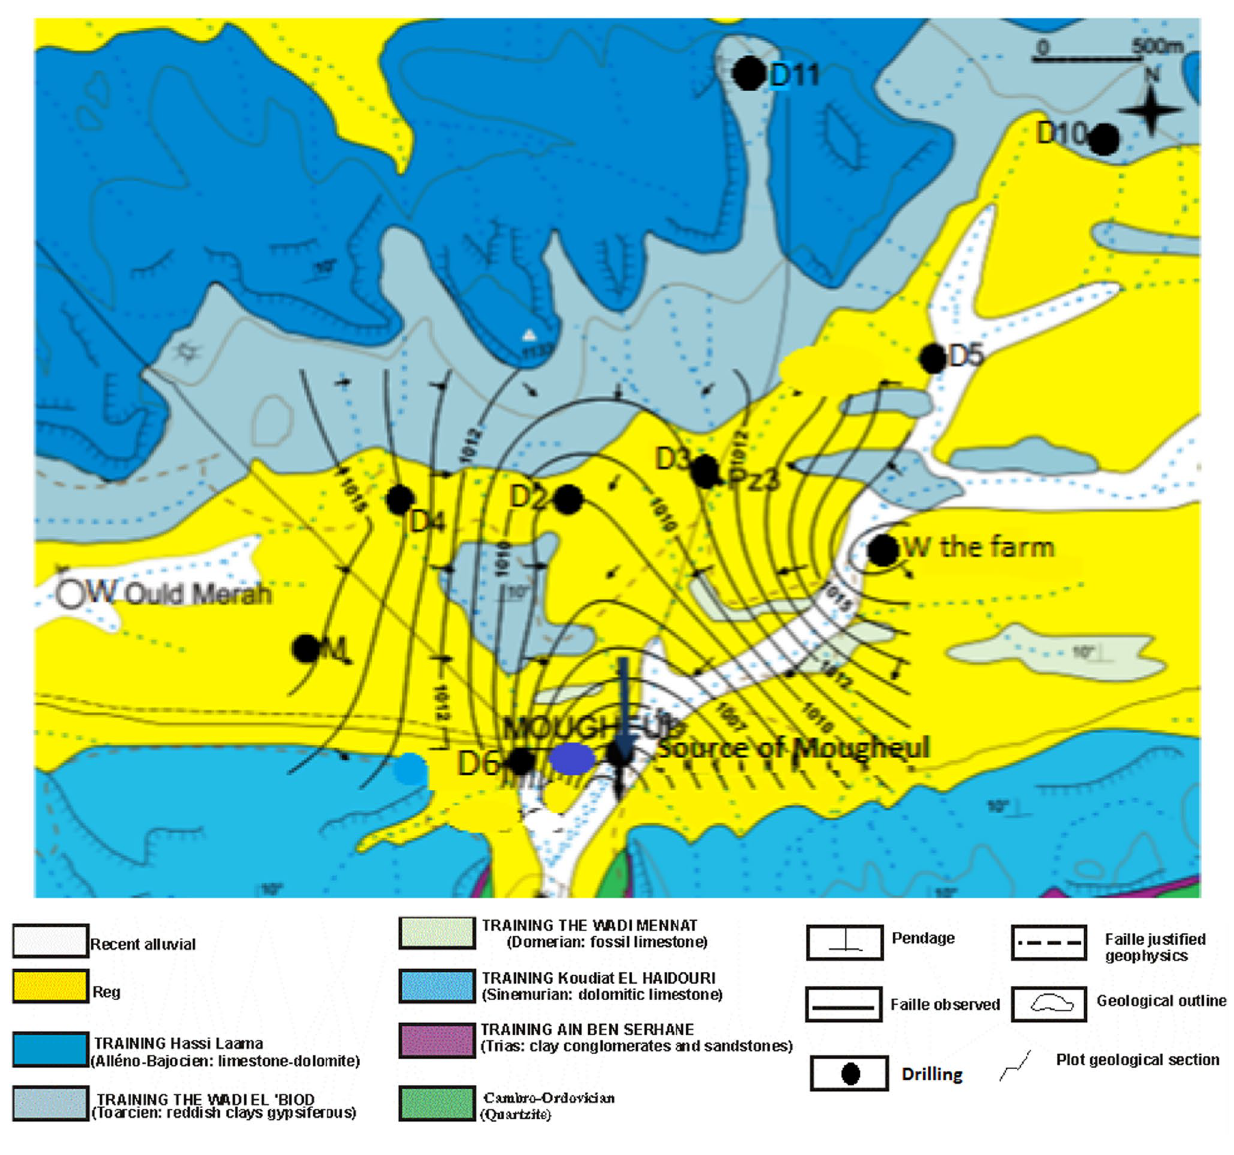
Fig. 4 Piezometric map of the lower Jurassic aquifer of Mougheul (Mebarki et al. 2021)